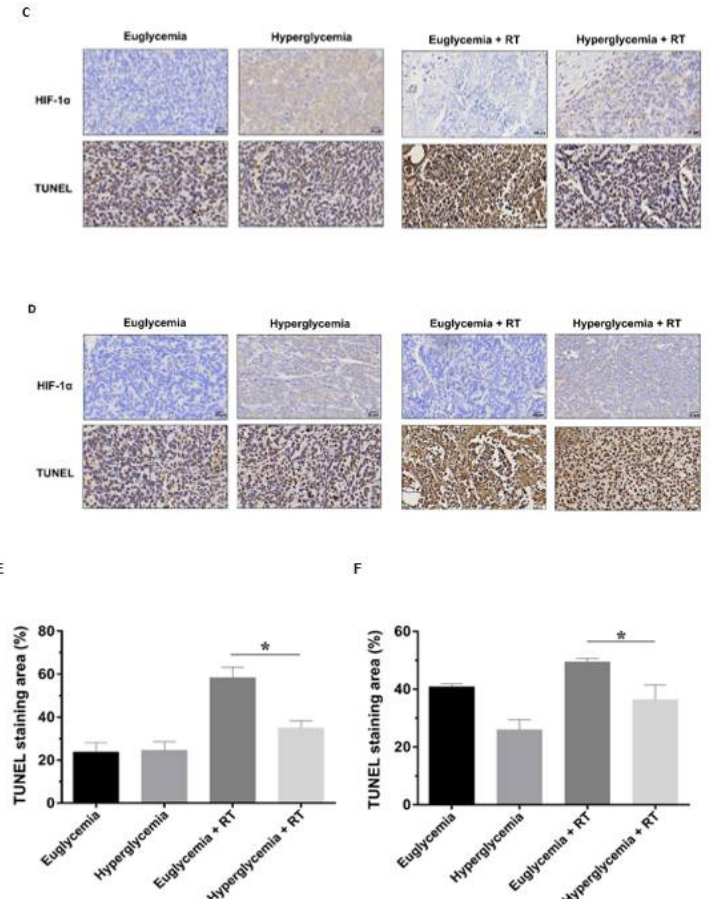
Figure 4. Effects of hyperglycemia promote the radioresistance of rectal cancer through overexpres- sion of HIF-1α. Establishment of HCT116 and SW480 for ectopic rectal cancer with euglycemia or hyperglycemia, respectively. After receiving radiotherapy or not three times per week, the tumor volumes of all groups were measured every two days until day 30. (HCT116, ( A ); SW480, ( B )) Rectal cancer masses were removed and collected subcutaneously after the measured endpoint (day 30) from the euglycemic or hyperglycemic mice. The HIF-1α level and apoptosis of cancer cells were detected by anti-HIF-1α antibody or Tunel assay in HCT116 ( C ) or SW480 ( D ). HIF-1α protein was stained in the cytoplasm (brown color) and Tunel was stained in the nuclear tumor cells. Tunel staining statistics ( E , F ) in HCT116 and SW480, respectively. Data are presented as mean ± SD ( n = 4; * p < 0.05). 3.6. LW6 Reduces the Radiation Tolerance of Rectal Cancer via Inhibiting the Expression of HIF- 1α in a High Glucose Environment To confirm that the induction of HIF-1α in a hyperglycemic environment was the main cause of radiation resistance, we treated rectal cancer with LW6 (an HIF-1α inhibi- tor) and radiation in a high glucose environment. HCT116 and SW480 were treated with